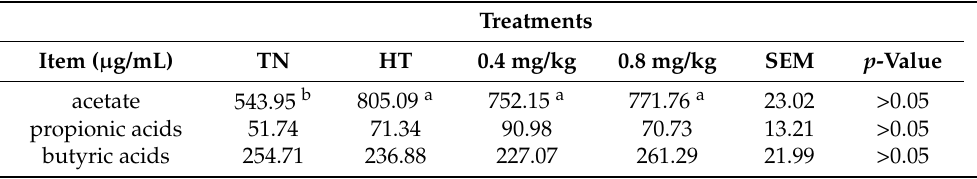
Table 7. Effects of chromium supplementation on SCFA